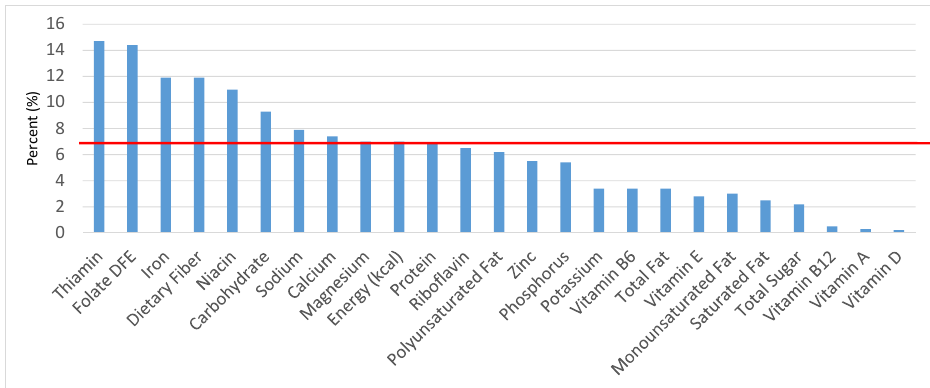
Figure 9. Breads, rolls and tortilla as sources of energy and nutrients for children and adolescents 9–13 years old ( N = 1730, daily intake data): DFE = Dietary Folate Equivalents; solid red line represents percentage of energy (kcal) provided in the diet relative to nutrients—nutrients above the red line show the grain food’s contribution to nutrient density